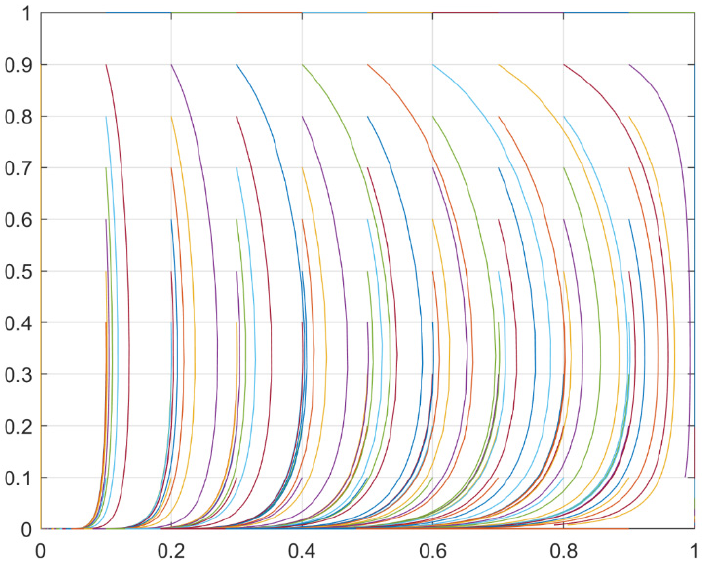
Figure 4. Dynamic evolution phase diagram for construction enterprises 1 and 2 in case (2) and (3).